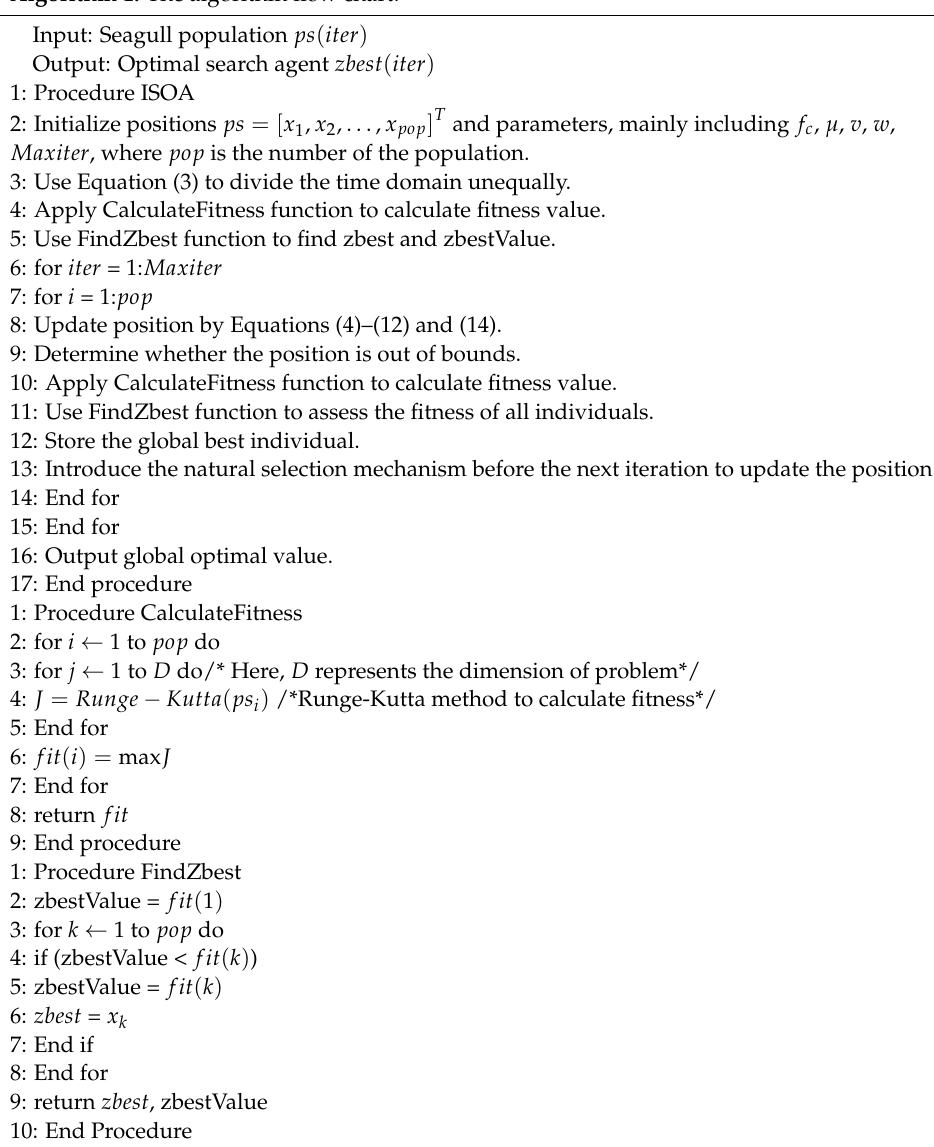
Algorithm 1: The algorithm flow